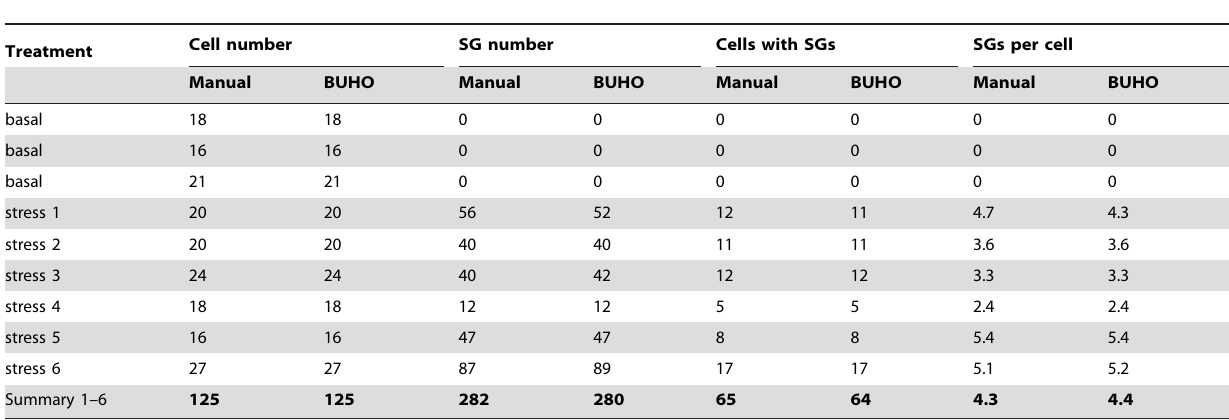
Table 1. Summary of manual and script analysis of images used for BUHO adjustment.